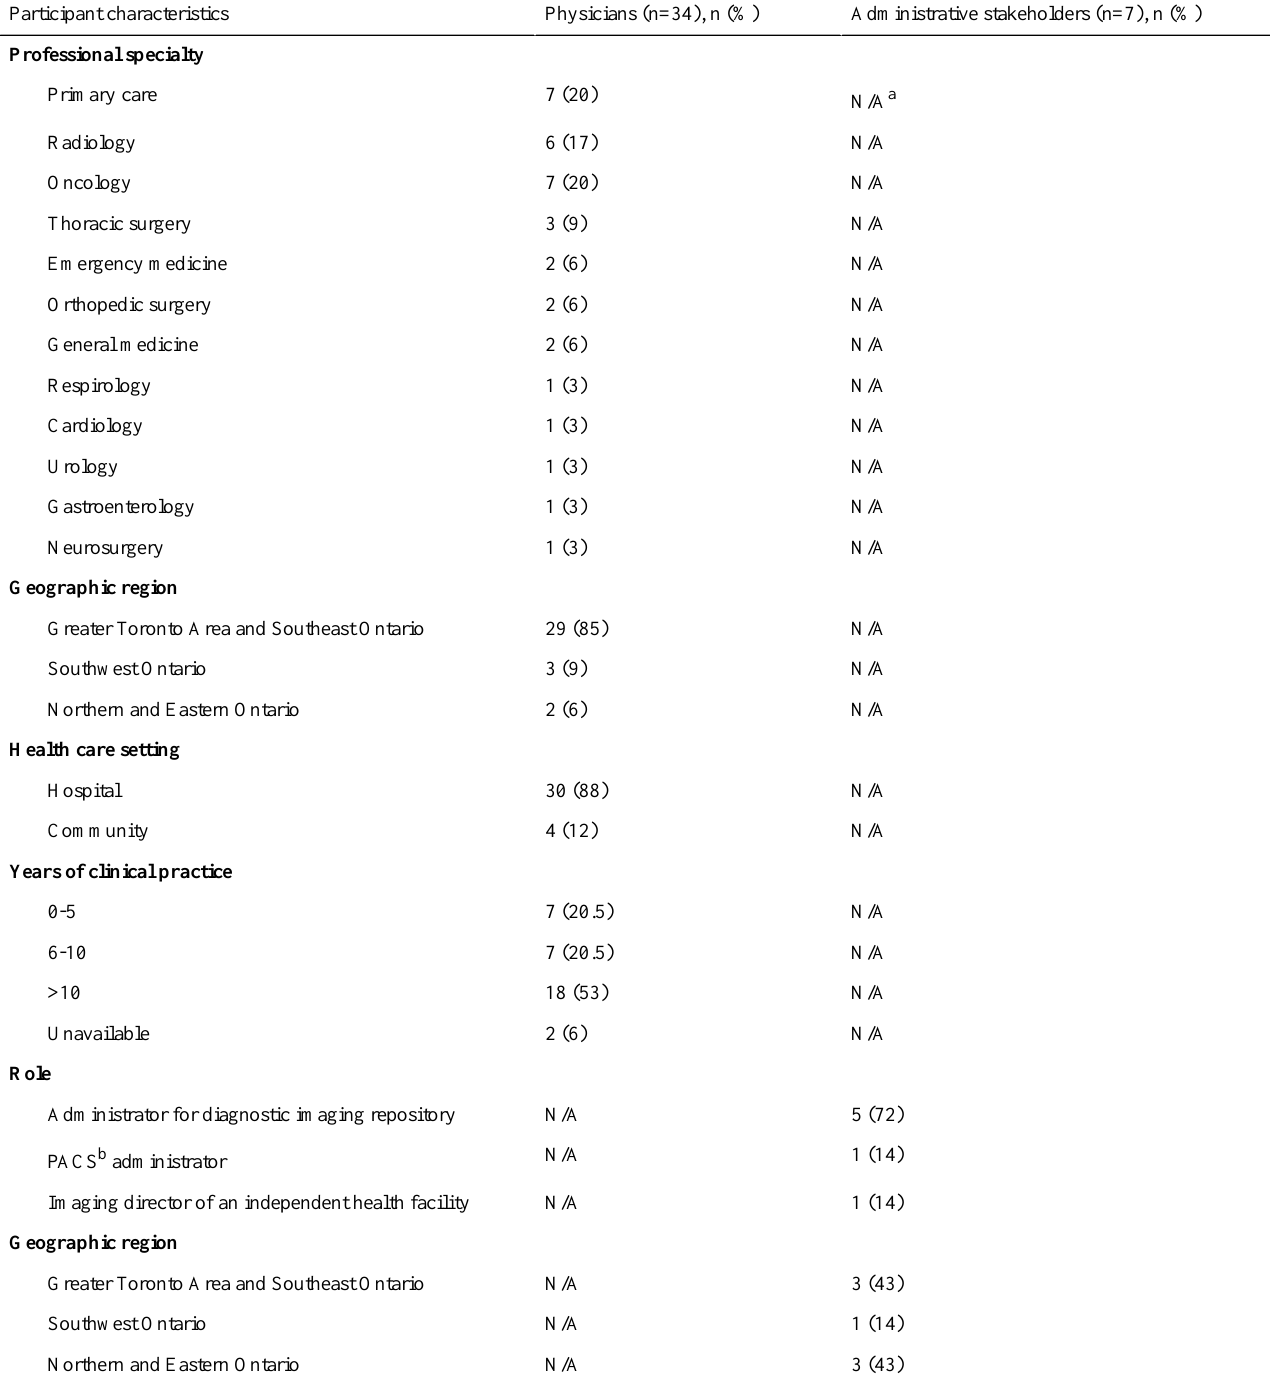
Table 1. Participant characteristics